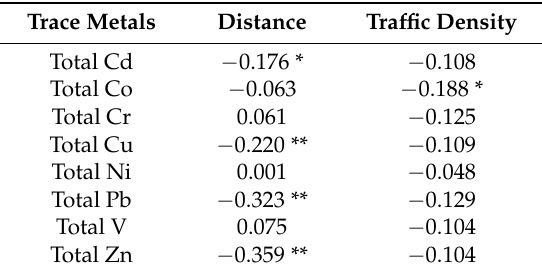
Table 2. Pearson correlation between the distance from the road, traffic density and total concentrations of trace metals in roadside agricultural soils ( n = 165). Trace